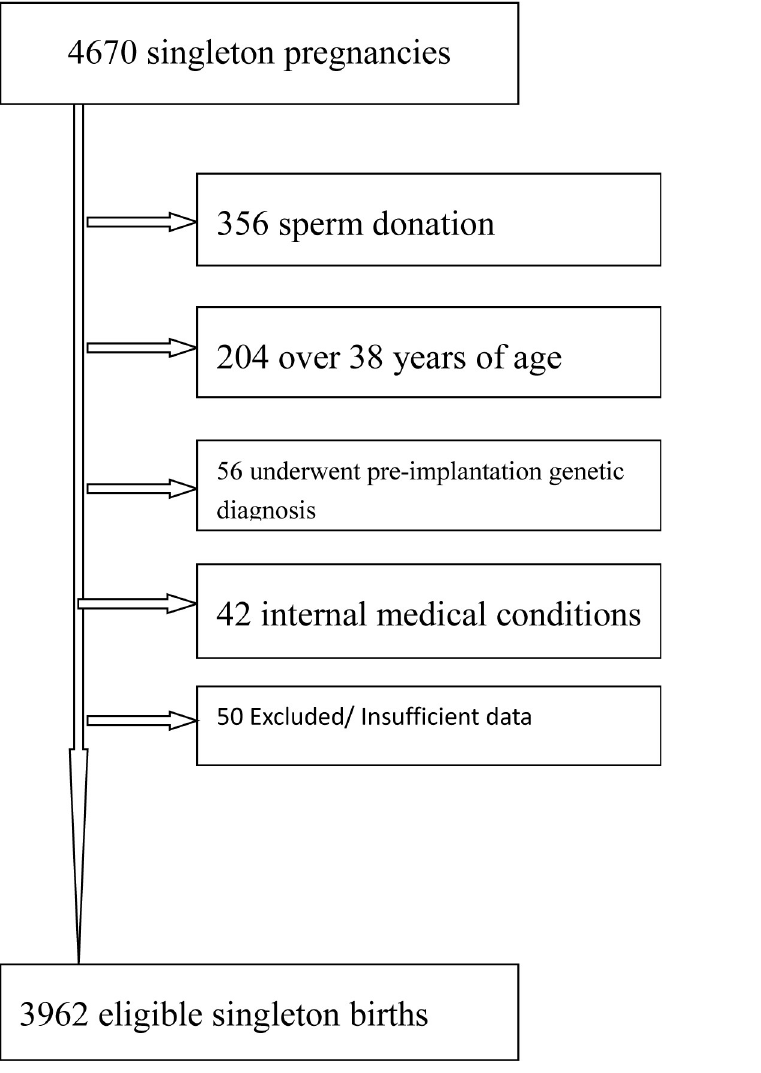
Fig 1. Flow chart depicting outcome of all singleton pregnancies